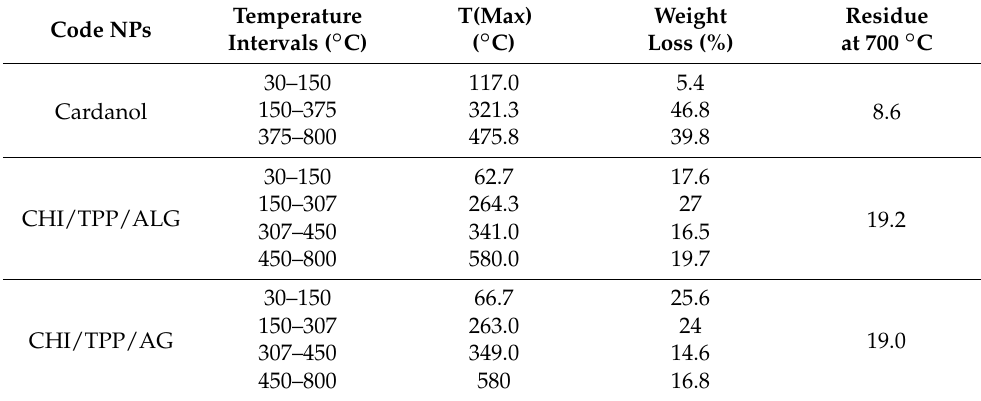
Figure 5. TGA curves for Cardanol and cardanol NPs CHI/TPP/ALG and CHI/TPP/AG; Mass (%) of the sample as a function of temperature, and first derivative (DTG) as a function of temperature. Table 2. Weight loss and degradation temperature for cardanol, CHI/TPP/ALG, and CHI/TPP/AG